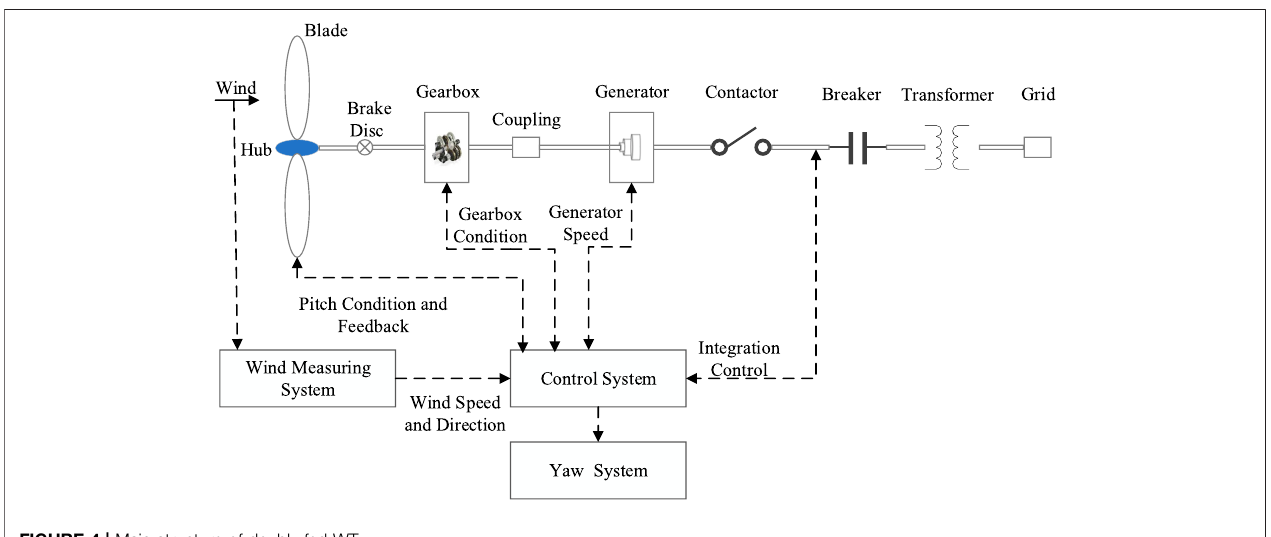
FIGURE 4 | Main structure of doubly fed WT.